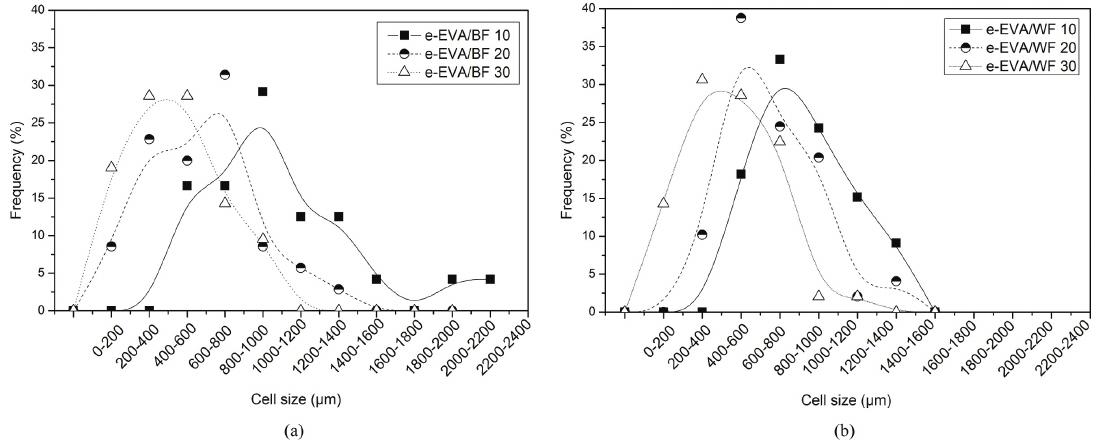
Figure 3. Cell size frequency distribution in cellular composites produced with (a) BF and (b) WF.